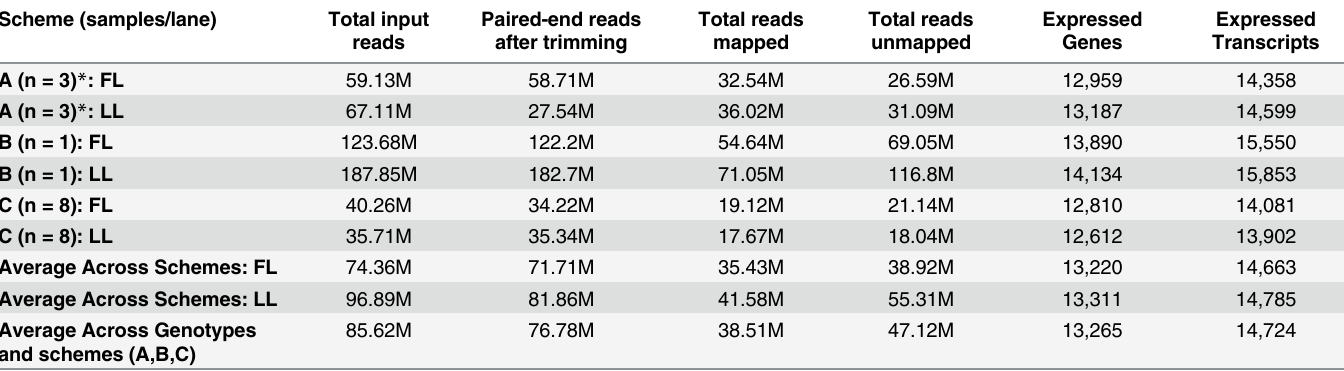
Table 1. Summary of RNA-Seq analysis of abdominal fat in divergent FL and LL chickens at 7 wk. Scheme